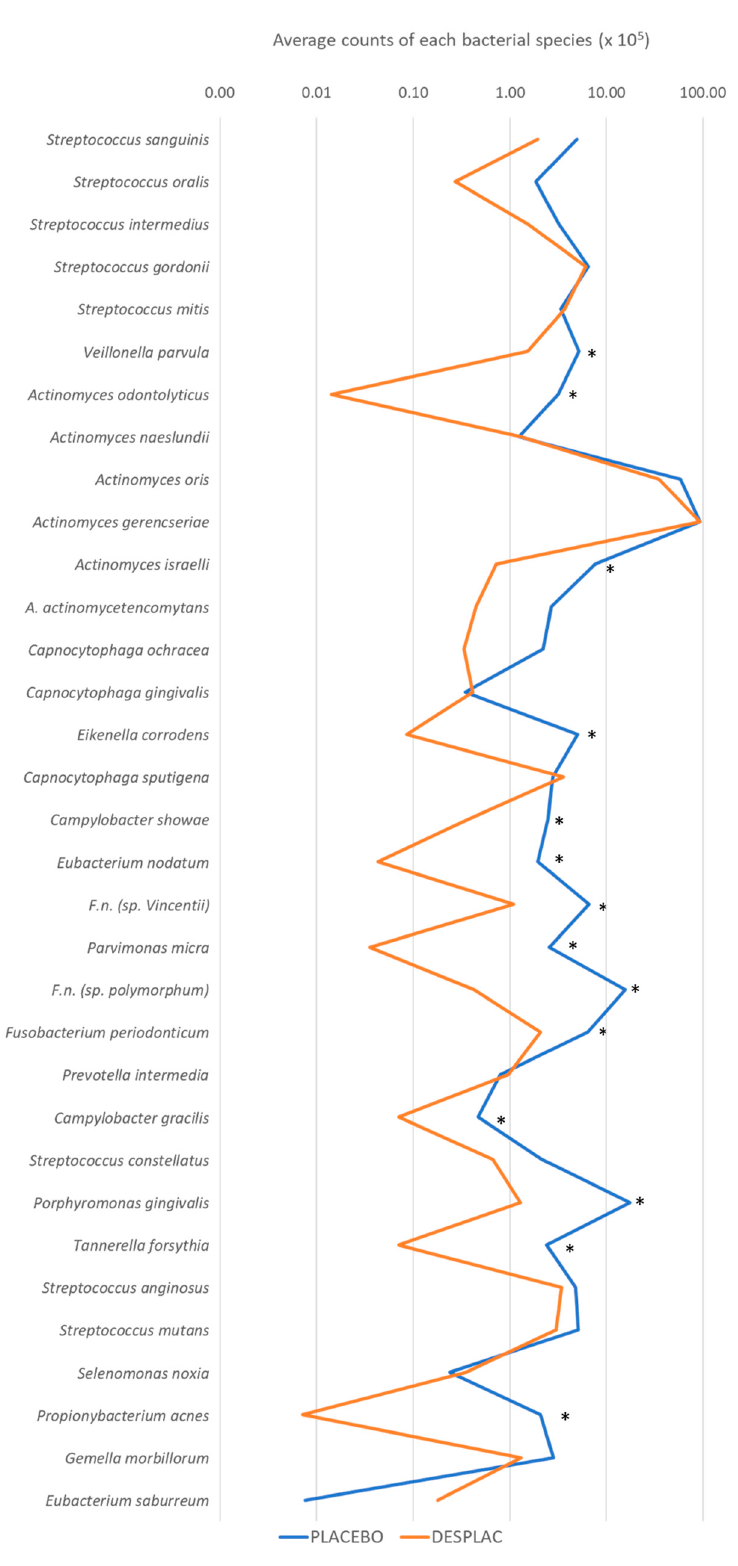
Figure 2. Average counts of each of the bacterial species present in the biofilm model under placebo and Desplac treatments. Statistical analysis performed using the Kruskal–Wallis test followed by Dunn’s post hoc test ( p ≤ 0.05). * Statistical difference between placebo and Desplac .